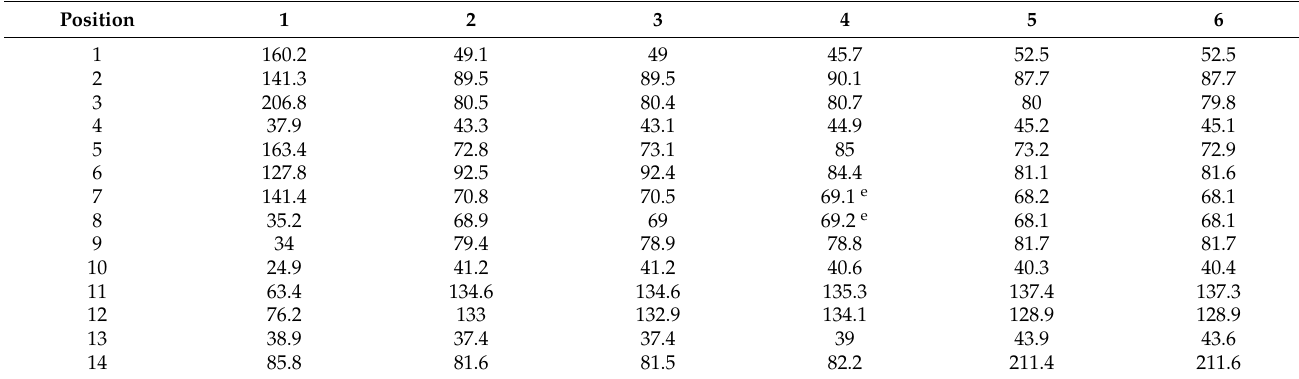
Table 2. 13 C NMR data of compounds 1 – 6 in CDCl 3 at 125 MHz ( δ C in